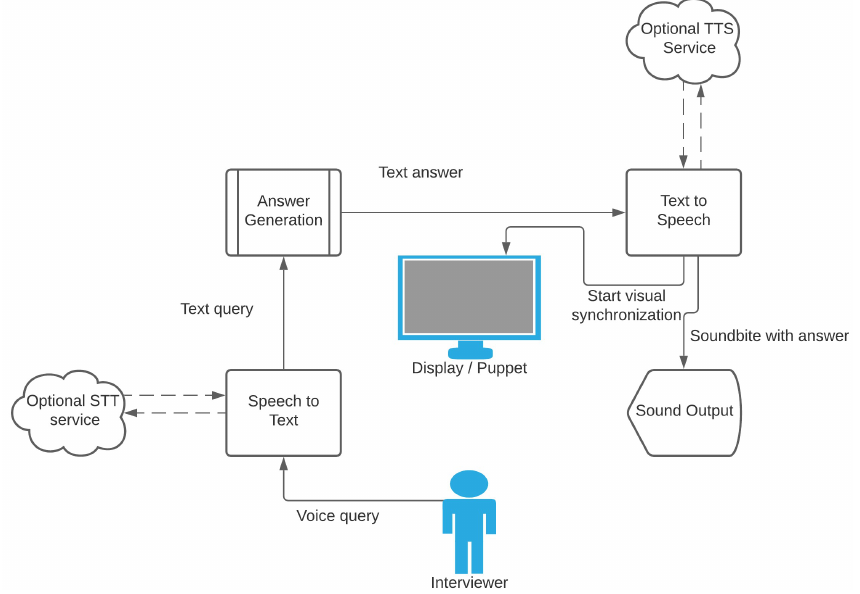
Figure 2. The general design of our systems follows a modular structure where each task is handled by a separate device or software. Alternatively, some modules such as the text to speech and speech to text modules could work as middle-ware for Cloud